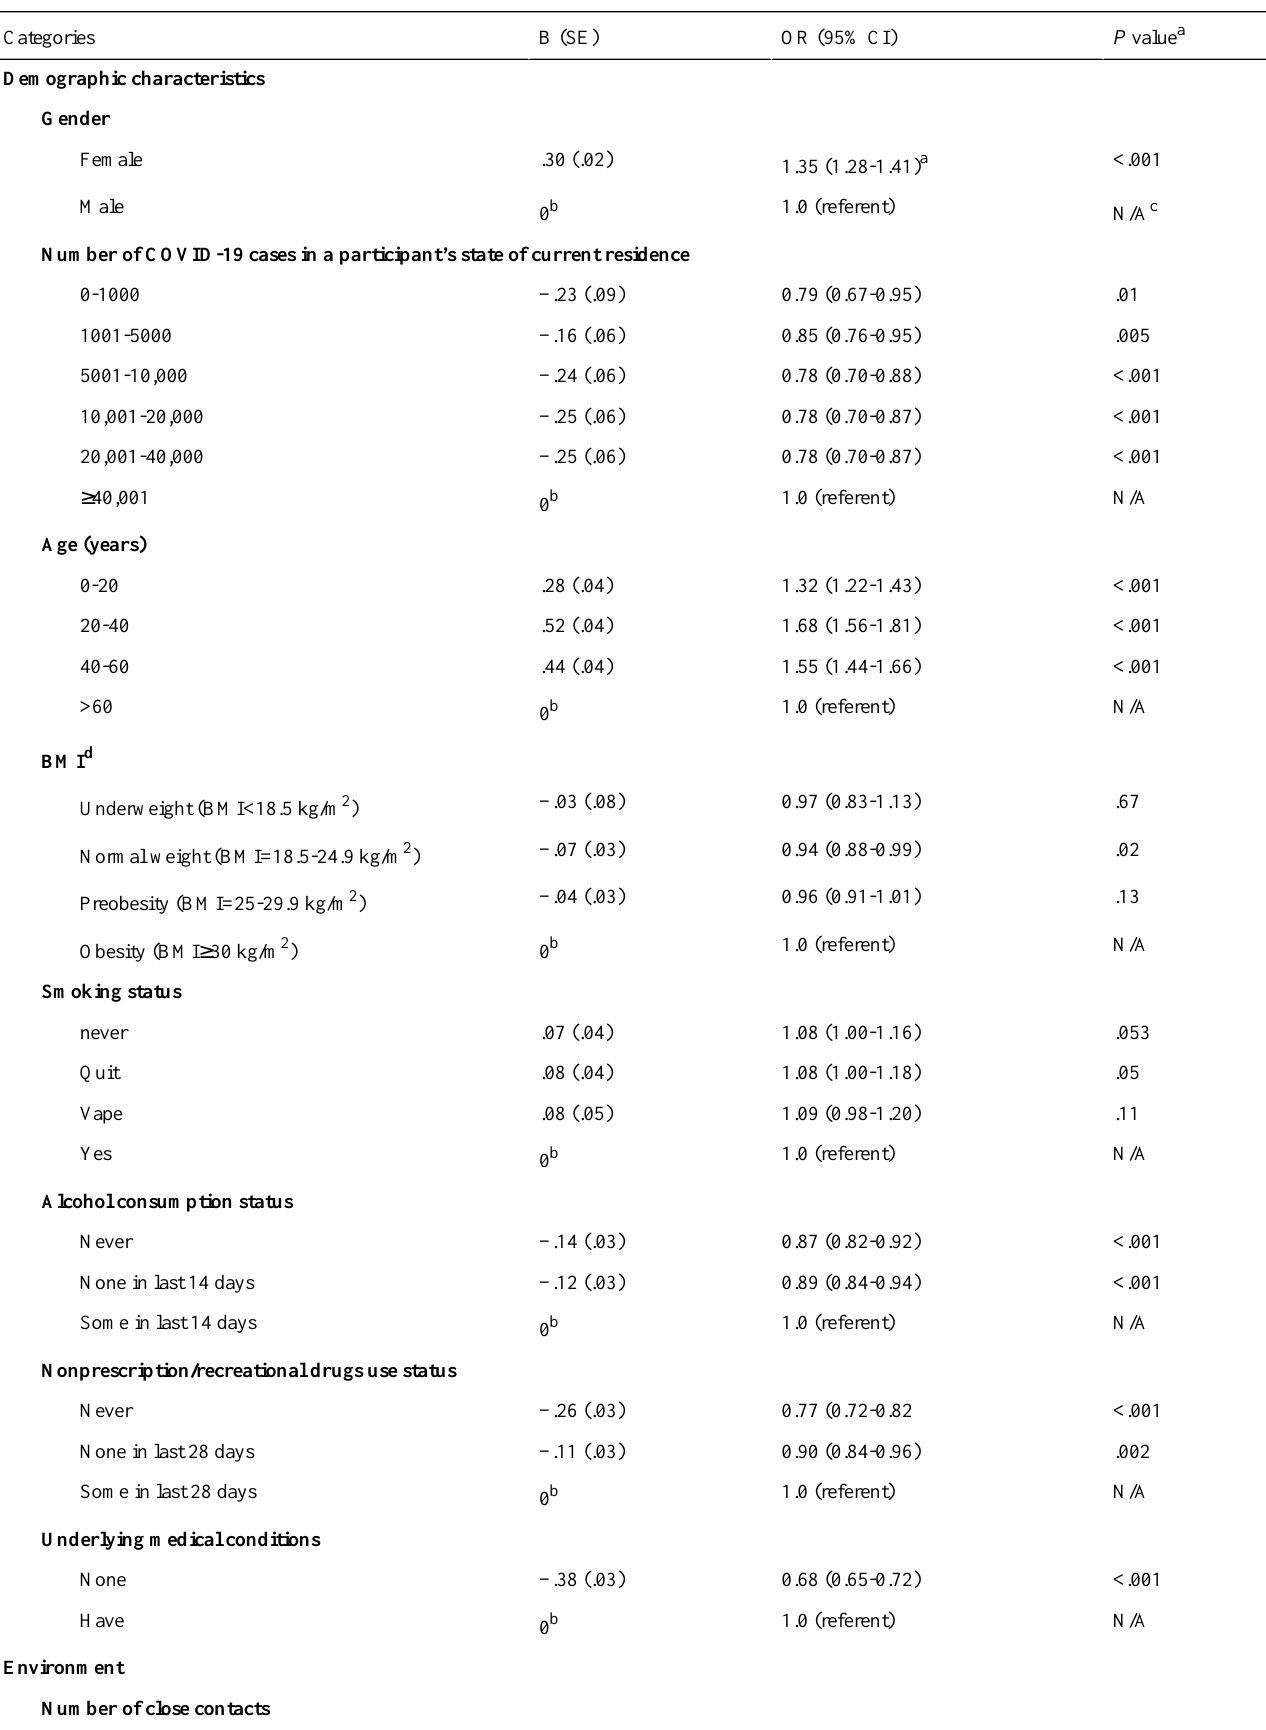
Table 3. Results of the logistic regression analysis of factors that were associated with participants’self-assessed probability of contracting COVID-19.